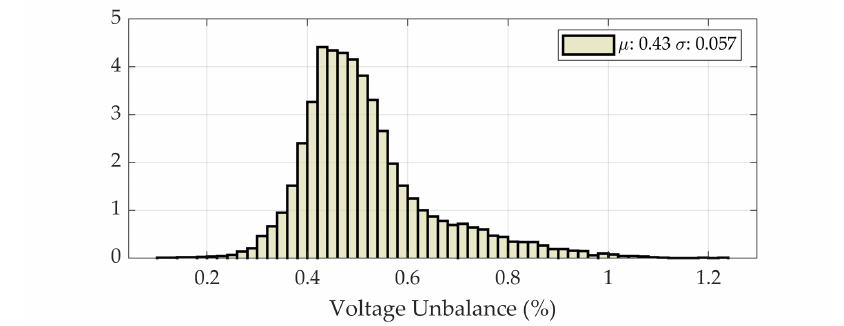
Figure 1. Background voltage